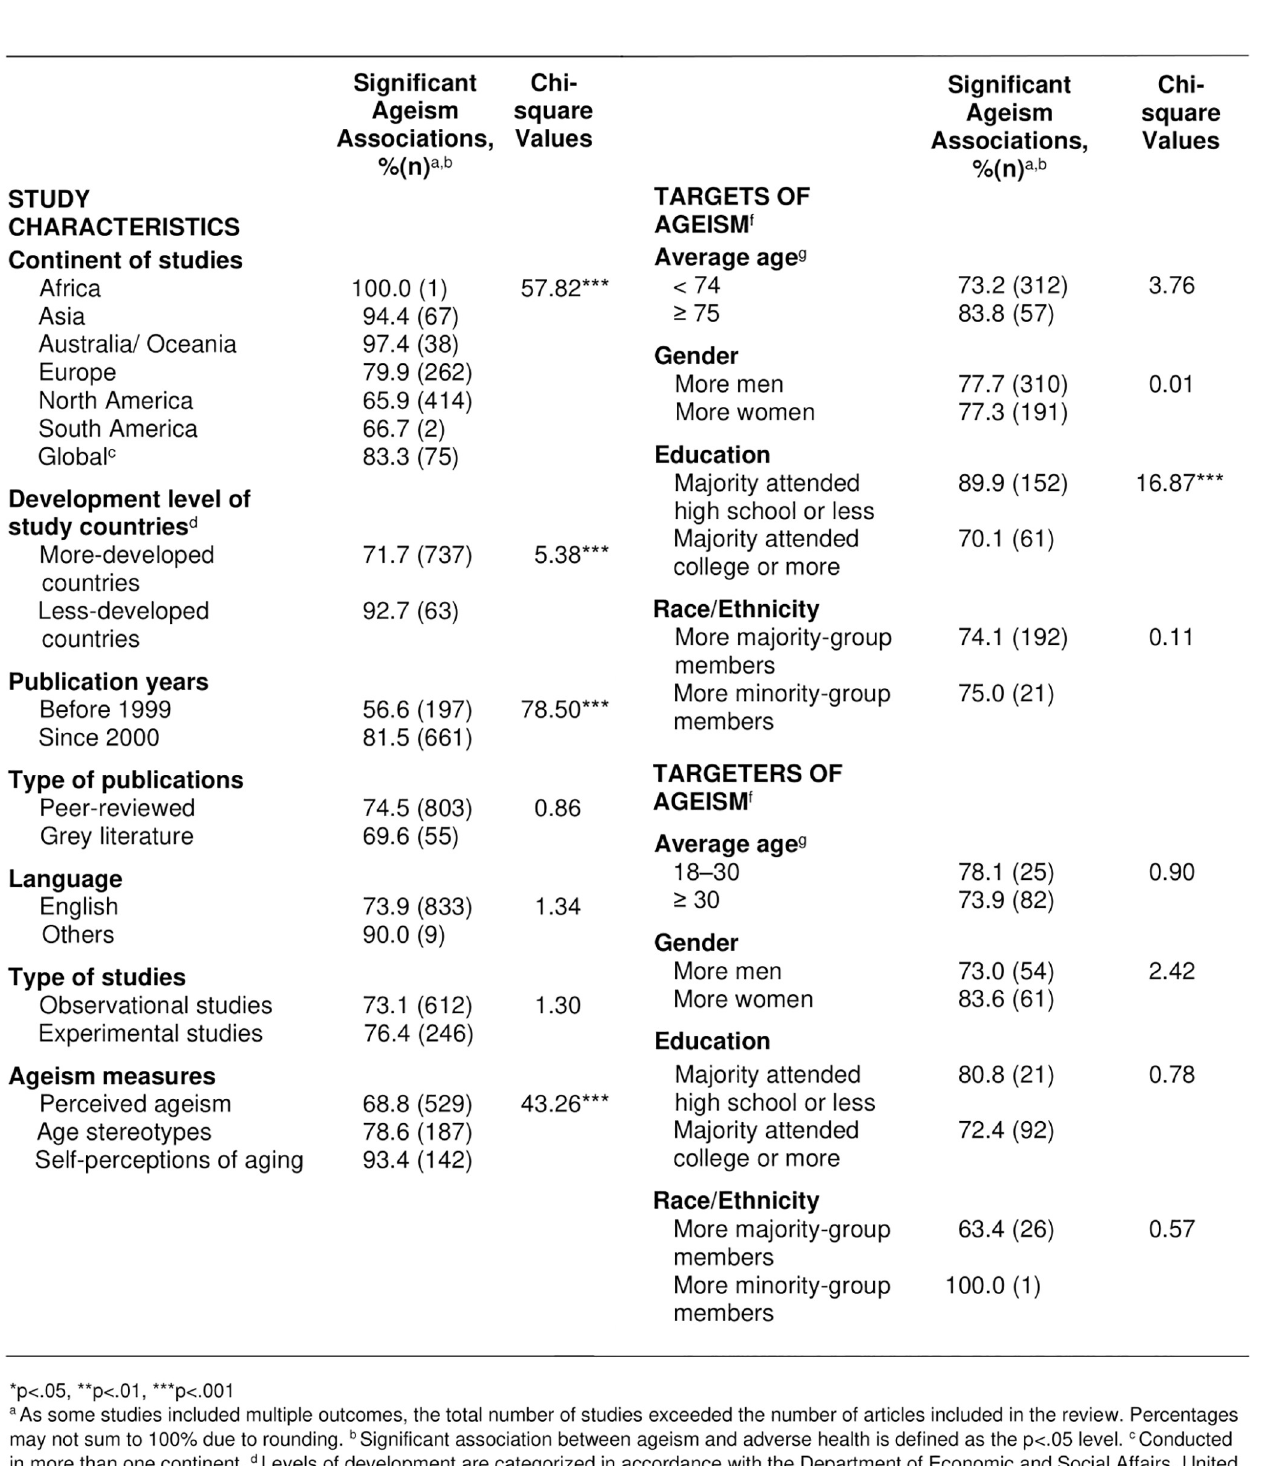
PLOS ONE | https://doi.org/10.1371/journal.pone.0220857 January 15,